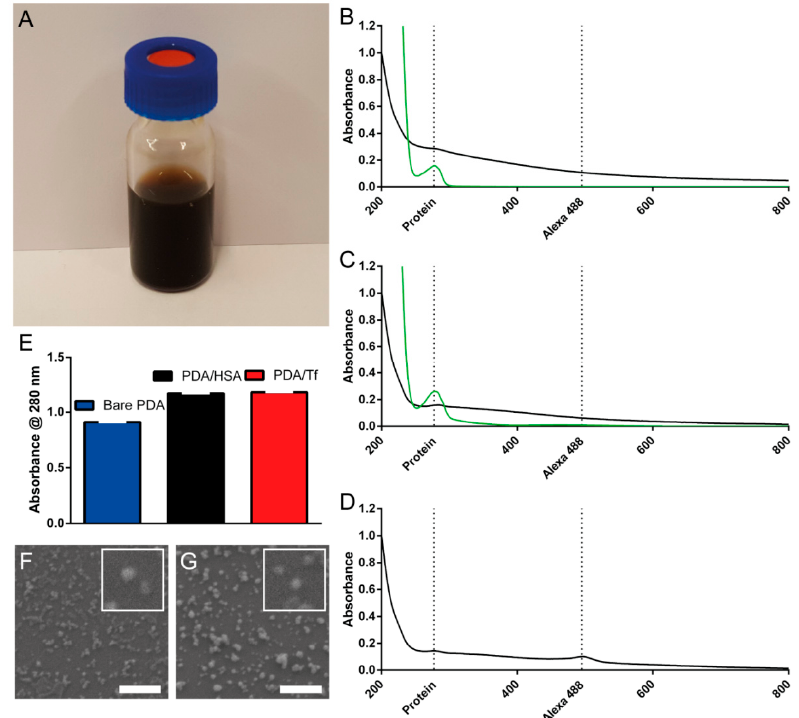
Figure 1. Characterization of the polydopamine particles, containing transferrin (PDA/Tf), polydopamine/human serum albumin (PDA/HSA), and PDA/Tf-A488 nanoparticles (NPs). ( A ) Photograph of an aqueous suspension of PDA/HSA NPs, and ( B ) absorbance spectra of the PDA/HSA with the subtracted background of bare PDA NPs (black line), and absorbance spectra of the HSA alone (green line). ( C ) The absorbance spectra of the PDA/Tf with subtracted background of the bare PDA NPs (black line), absorbance spectra of the Tf alone (green line), and ( D ) the absorbance spectra of the PDA/Tf-A488 (black line). The dotted lines represent typical absorbance maxima for the proteins (270–280 nm) and the Alexa 488 fluorophore (495 nm), in panels ( B , C ). ( E ) The absorbance measurement of the bare PDA NPs, PDA/HSA NPs, and PDA/Tf NPs, at 280 nm. The difference in absorbance of the bare PDA NPs and the PDA/protein NPs can be attributed to the proteins present. ( F ) Scanning electron micrograph of the drop-casted PDA/Tf NPs, and ( G ) scanning electron micrograph of the drop-casted PDA/HSA NPs. Scale bar = 500 nm.